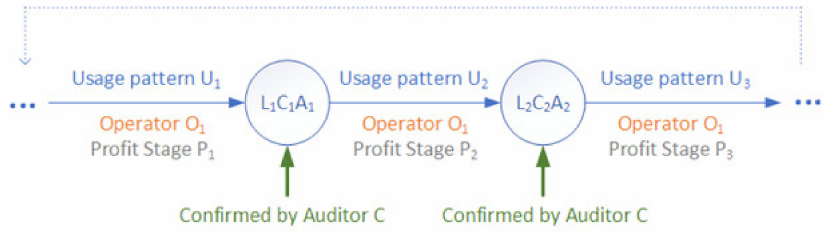
Figure 3. Multiple sequential asset